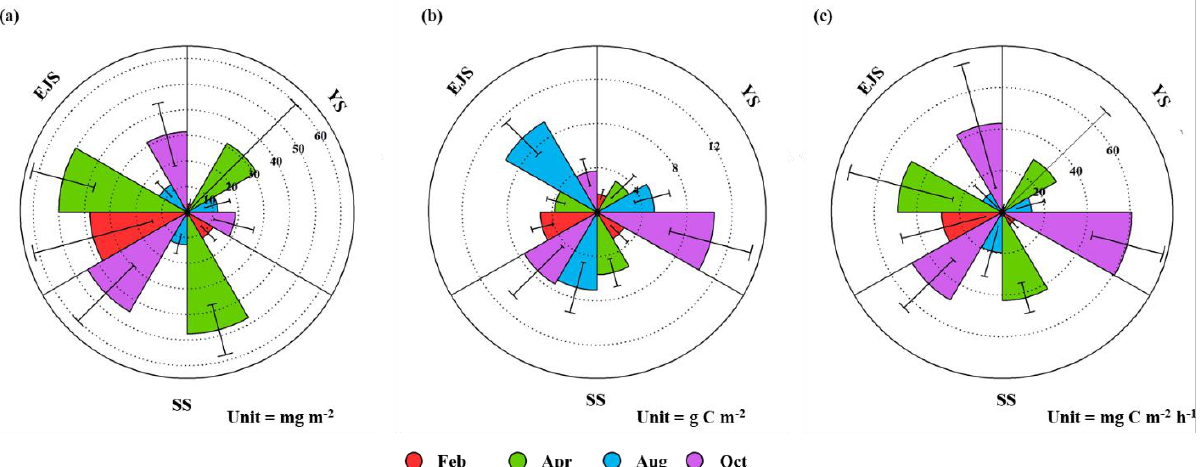
Figure 6. Nightingale rose diagrams of mean chl- a ( a ) and POC ( b ) concentrations and primary productions ( c ) in the YS, the SS, and the EJS,